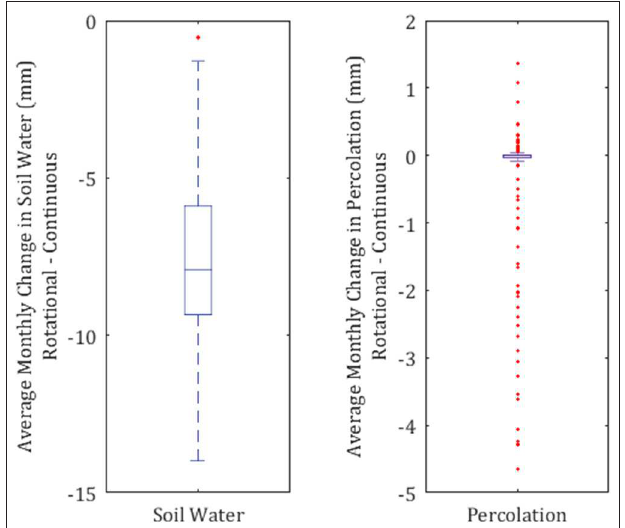
FIGURE 4 | Distribution of monthly simulated differences in soil water and percolation based on the two grazing scenarios. Change in monthly parameters is calculated by subtracting continuous results from rotational results for both soil water and percolation, meaning that when the value is negative there was more soil water or percolation under the continuous scenario and vice versa.